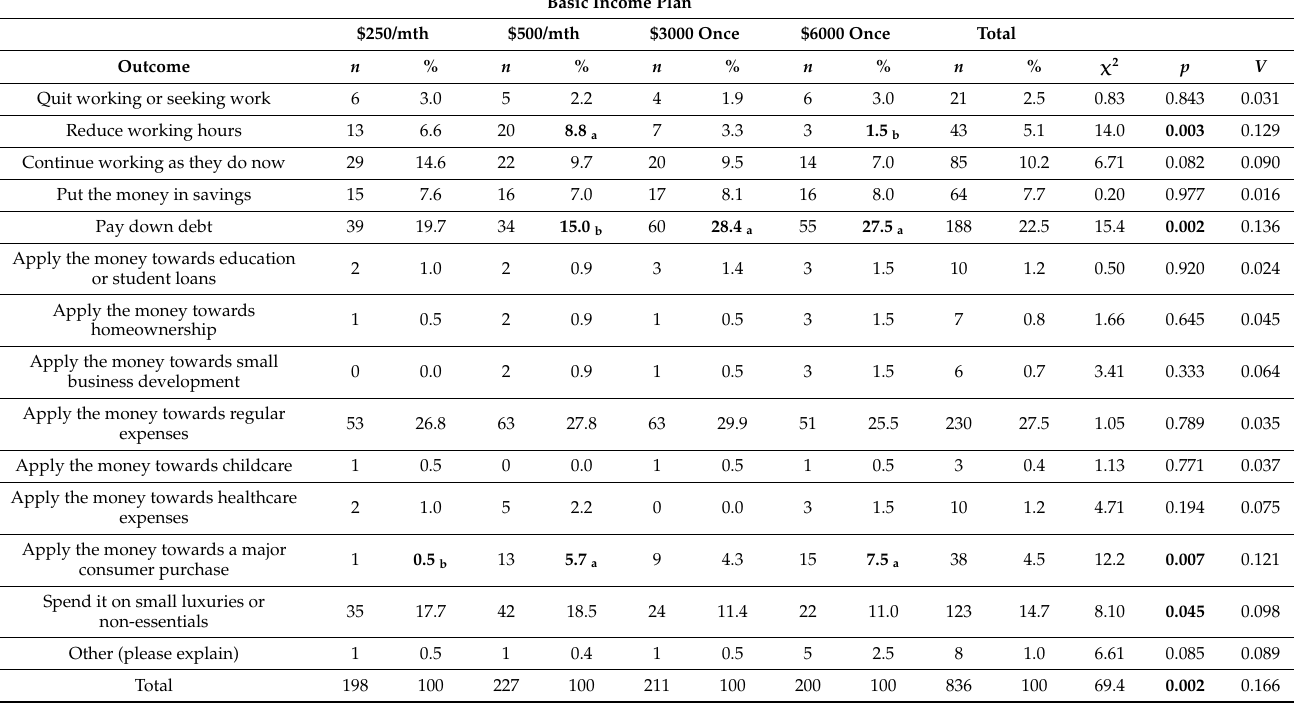
Table 2. Cross-tabulation of perceived outcomes of the adoption of UBI plans by plan